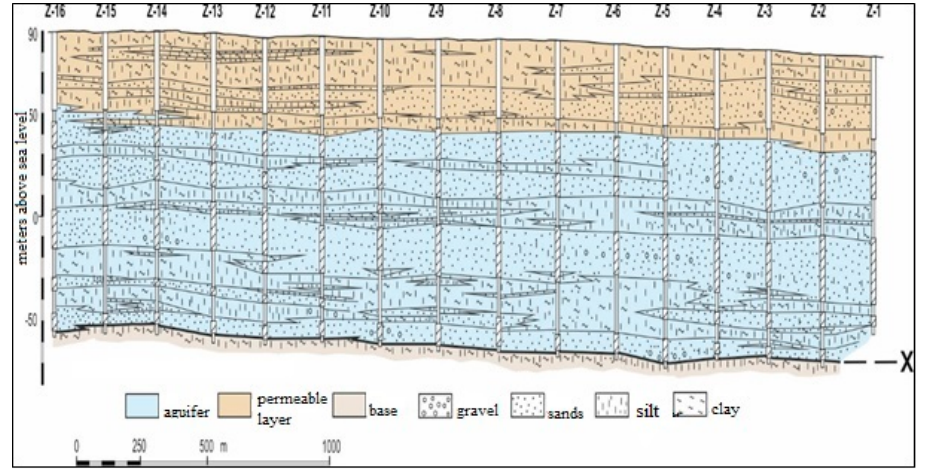
Figure 2. Profile of Quaternary deposits affected by wells of Vinogradi Pumping Station.